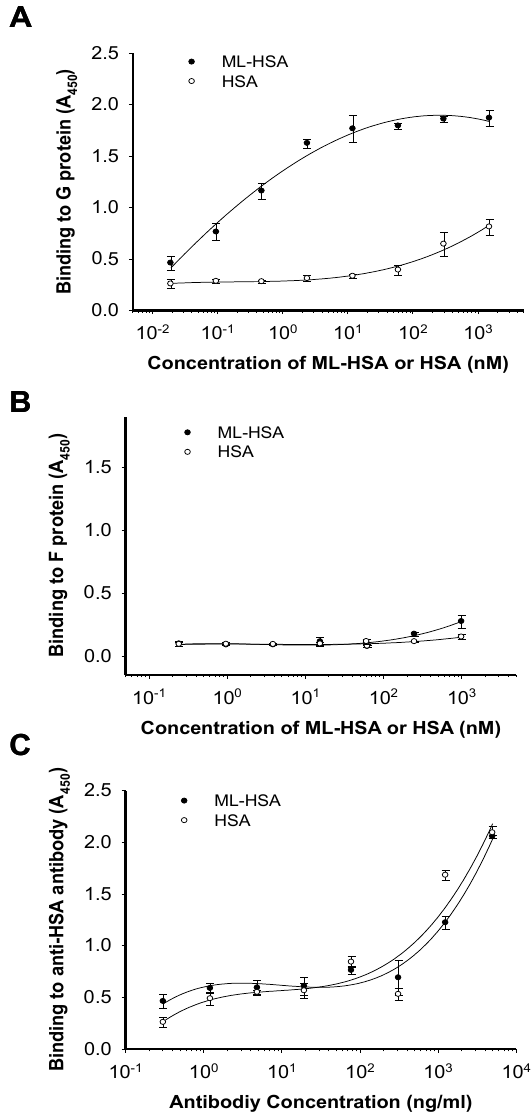
Figure 6. ML-HSA bound to RSV G protein. The wells of plates were coated with RSV G protein, HSA and ML-HSA, respectively. Binding of ML-HSA to RSV G protein ( A ), F protein ( B ) or anti-HSA antibody ( C ) was determined by ELISA. Each sample was tested in triplicate, and the experiment was repeated twice. The data from one representative experiment were presented in mean ±